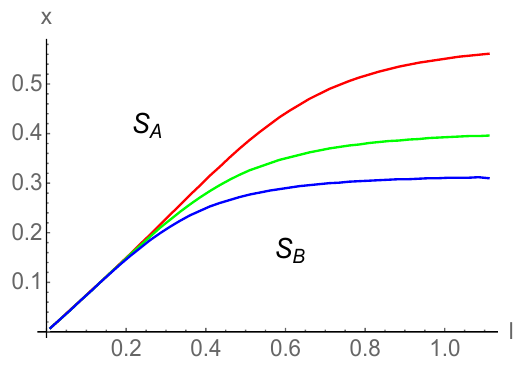
Figure 16 . Two strip phase diagram in the decon(cid:12)ned phase for various values of temper- ature. Here (cid:22) = 0 is (cid:12)xed and red, green and blue curves correspond to T=T c = 1 : 2, 1 : 6 and 2 : 0. In units GeV.